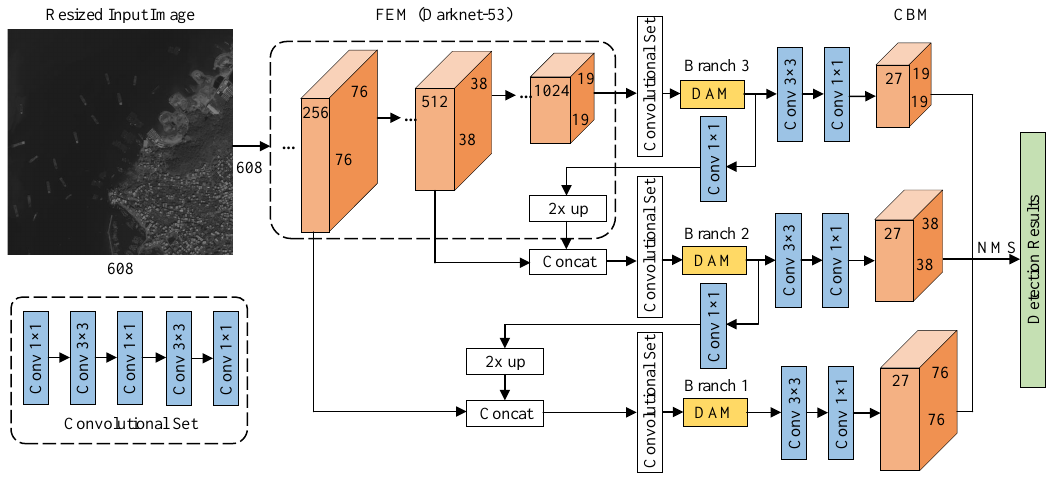
Figure 1. Architecture of ImYOLOv3 for ship